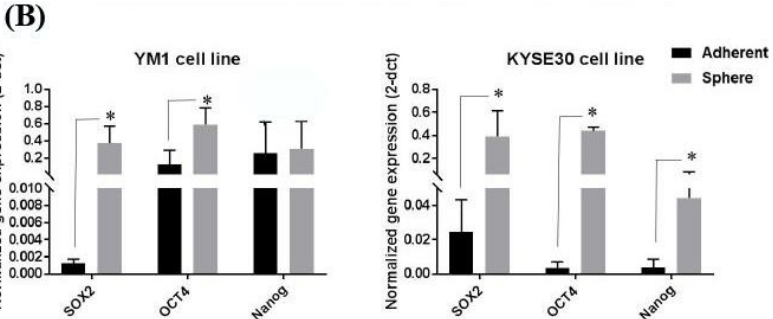
Figure 1. Stemness characterization of the YM1- and KYSE30-derived spheres. ( A ) shows the adherent form of the original cells and the tumorspheres in passage 3. ( B ) shows increased gene expression of the pluripotency regulators (SOX2, OCT4A, and Nanog) in spheres of compared to the adherent cells, measured by qRT-PCR. * p -value < 0.05.